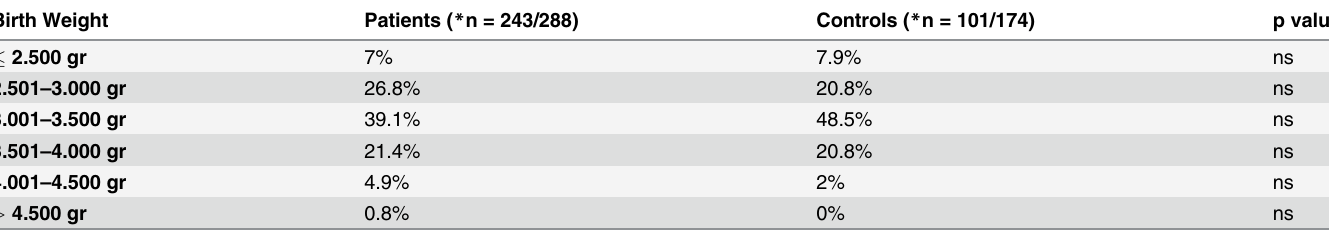
Table 4. Percentages of patients and controls according to birth weight categories. Birth